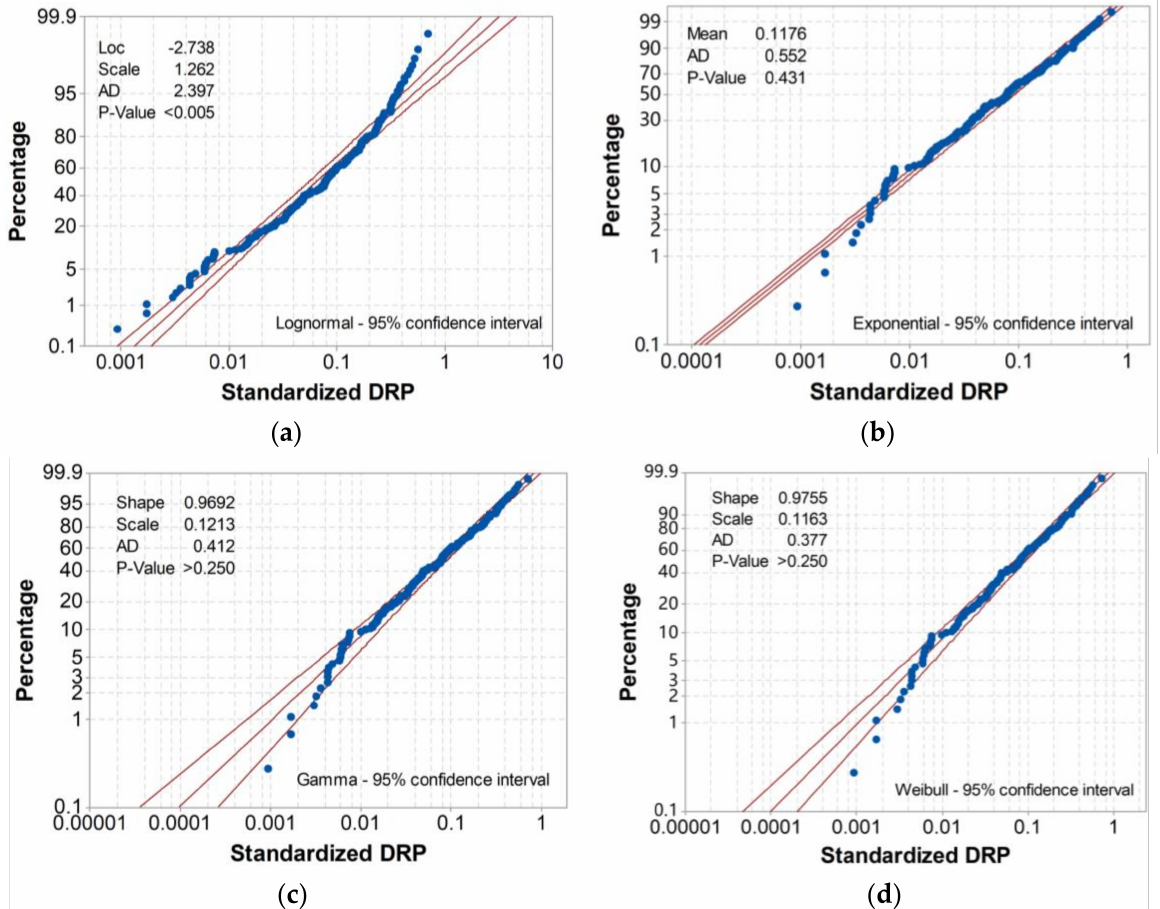
Figure 5. Probability plot of DRP. ( a ) Lognormal > 95% confidence interval; ( b ) Exponential > 95%